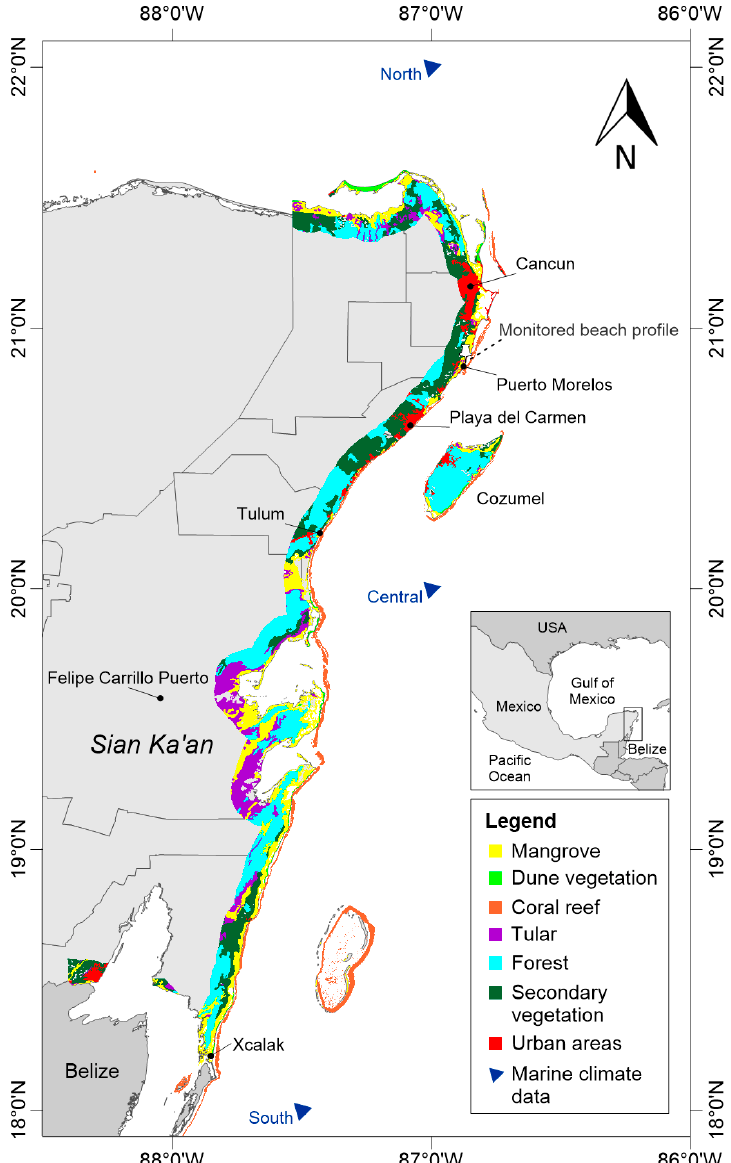
Figure 2. Coastal ecosystems (10 km strip) on the Mexican Caribbean. Data obtained from [18,19] .